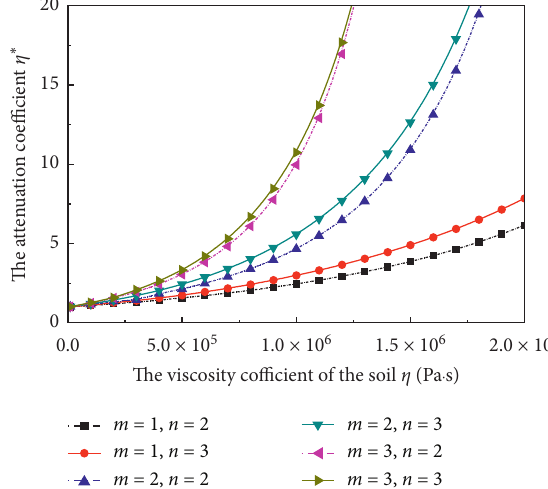
Figure 3: Relationship between attenuation coefficient and changes in soil viscosity for different